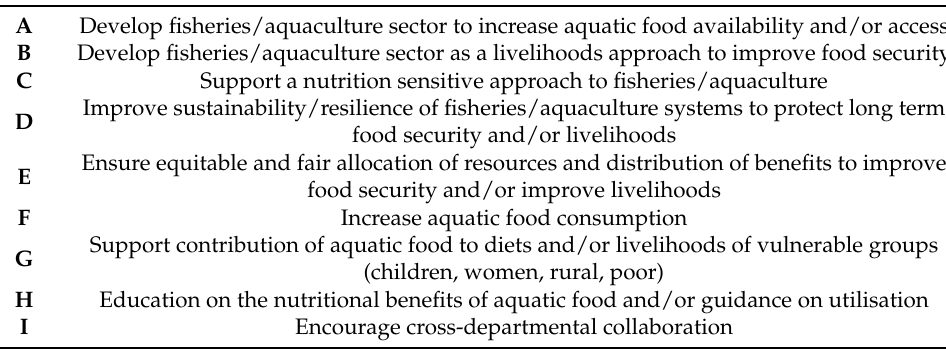
Table 2. Context of linkage between FNS and